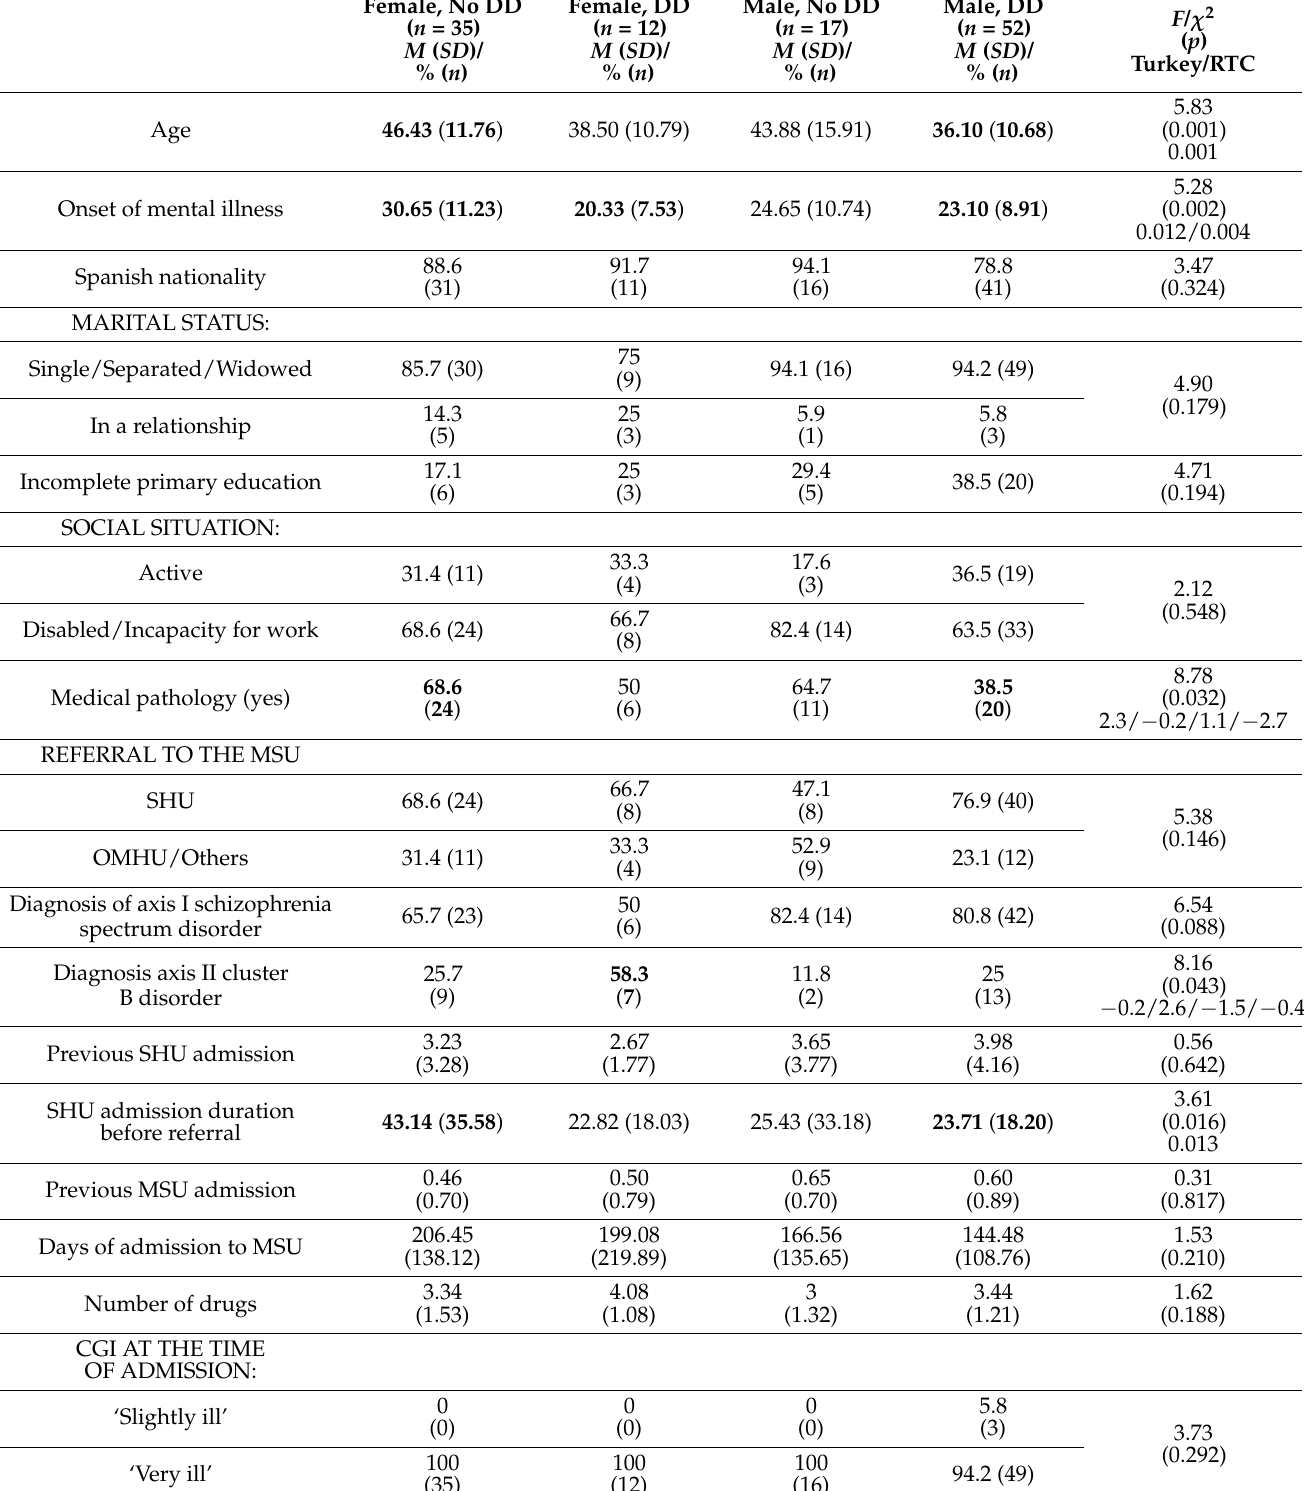
Table 4. Results disaggregated by sex and the presence or absence of dual